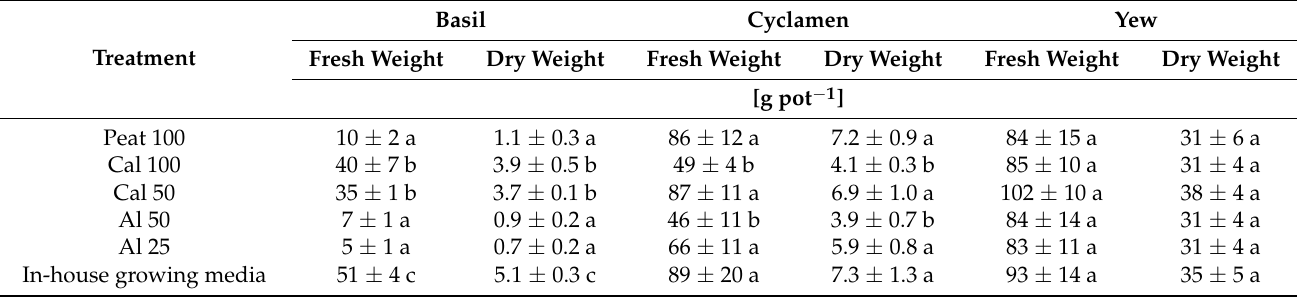
Table 8. Experiments under practical conditions with basil, cyclamen, and yew. Aboveground biomass weights, n = 10. Variance analysis: Kruskal–Wallis (basil, yew), ANOVA (cyclamen), post hoc test: pairwise t test, p < 0.05. Different letters indicate significant differences among treatments. Explanation of treatment names see Table